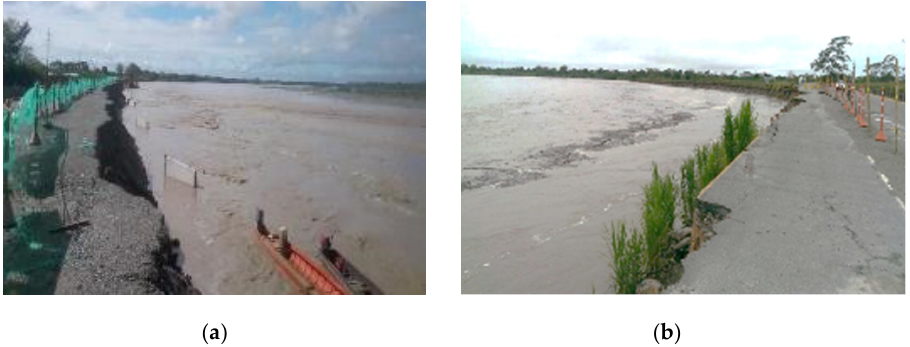
Figure 31. Ariari River, PR68: surface condition of the flows shows the transfer of the thalweg to the center of the riverbed by the panels. ( a ) Downstream view; ( b ) upstream, facing the semi-destroyed road. Compare with Figure 24 (Source: Hidroconsulta).